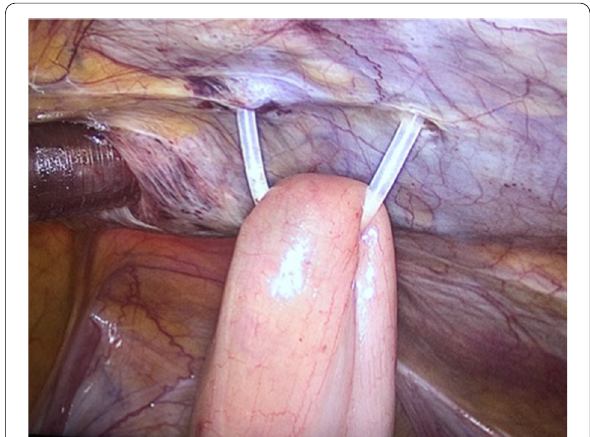
Fig. 2 Hidden ileostomy: the hidden ileostomy is brought under the abdominal wall then the silicone loop is fixed to the skin in the right lower